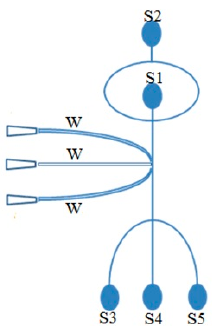
Figure 9. Schematic layout of the microfabricated flow cytometer chip. S1: sample inlet, S2: sheath inlet, S3: side flow switching inlet, S4: default waste outlet, S5: target particle outlet, W: waveguides.